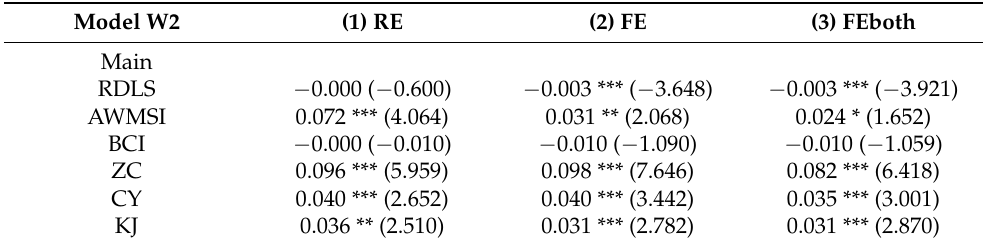
Table 9. Spatial Durbin model results with W2